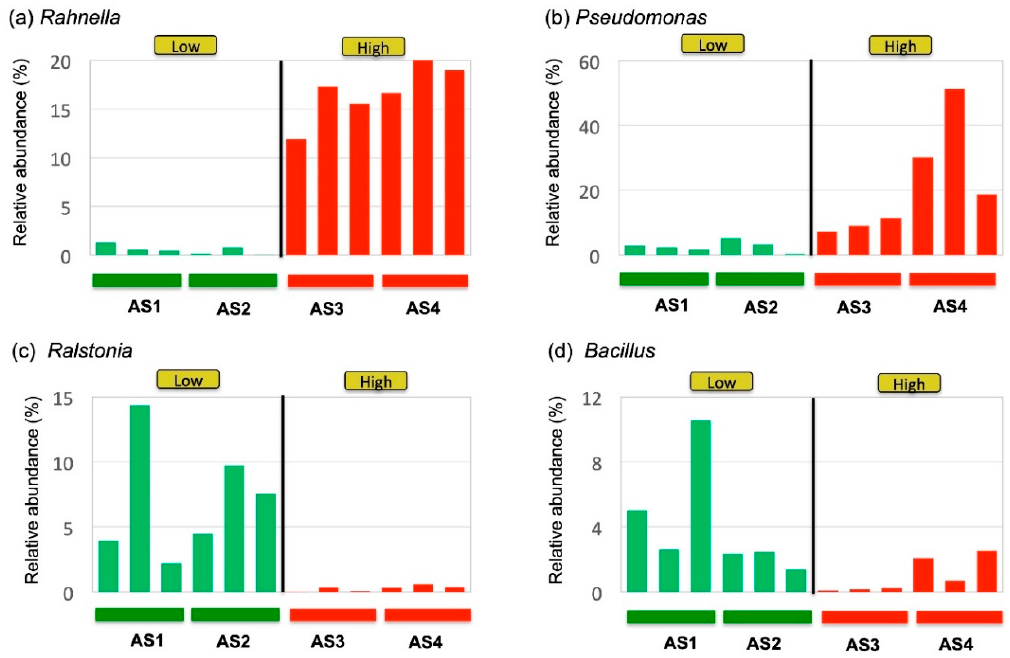
Figure 5. Plots of bacterial genera correlated with the in vitro immunostimulatory activity, ( a ) Rahnella and ( b ) Pseudomonas , and Low activity, ( c ) Ralstonia and ( d ) Bacillus . Three independent replicates were made for each sample to show the variability of microbial community within the same sample. The genera Rahnella and Pseudomonas were abundant in High-activity samples (AS3 and AS4), whereas Ralstonia and Bacillus were abundant in Low-activity samples (AS1 and AS2).